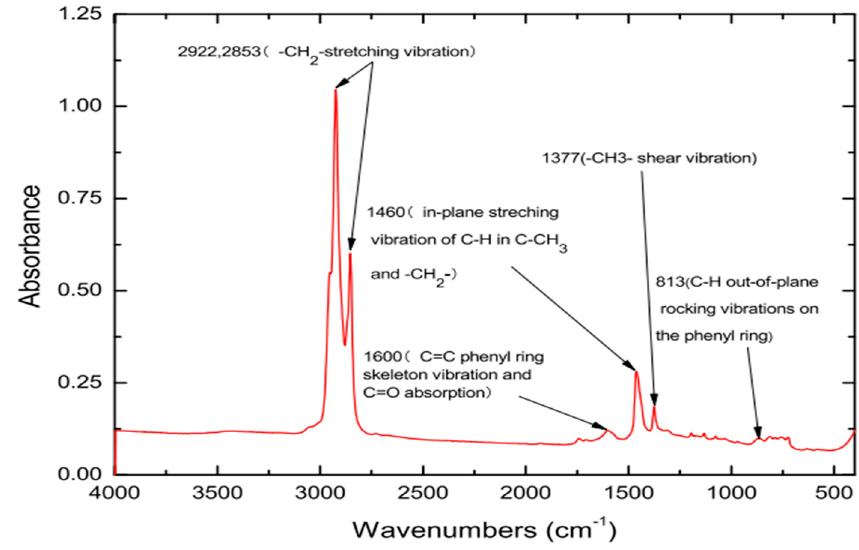
Figure 2. FTIR spectrum of original asphalt.